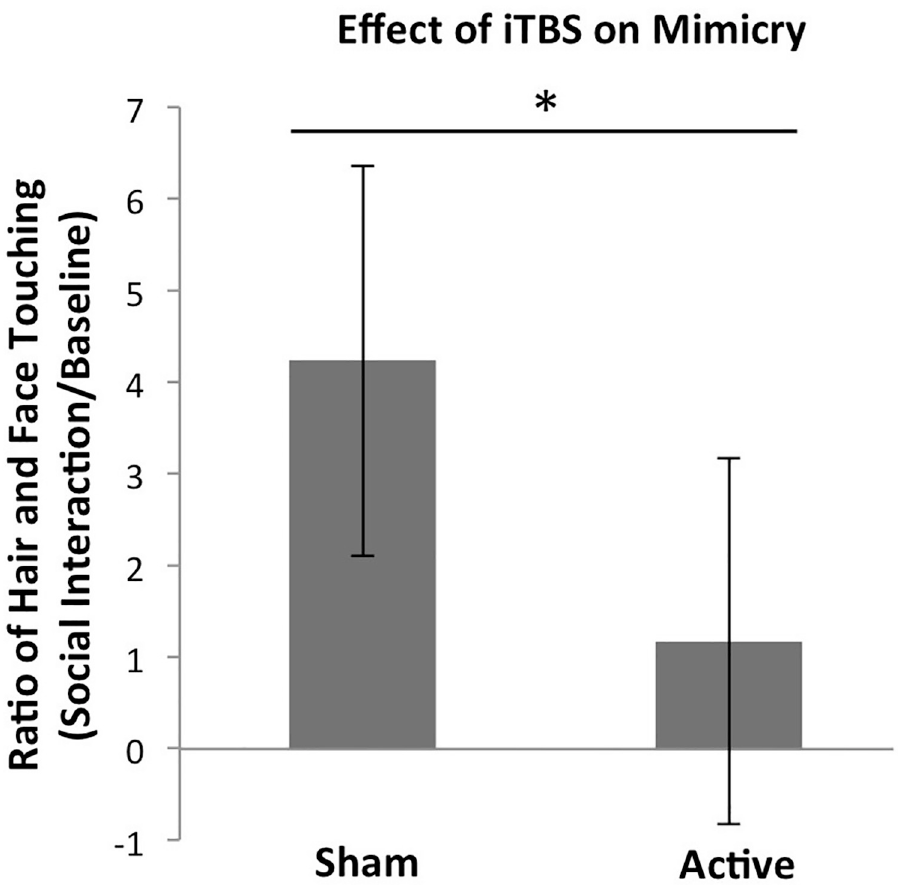
active iTBS mimicked the confederate significantly less. This suggests that active iTBS increases the distinction between self and other resulting in less behavioral mimicry. Error bars represent 95% confidence